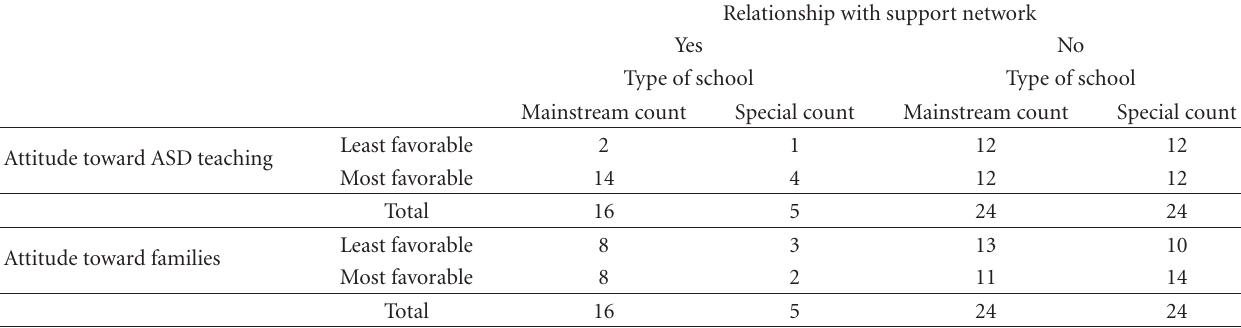
Table 2: Distribution of teachers relative to attitude towards the teaching of pupils with ASD, attitude towards their families, ASD network membership, and type of school.